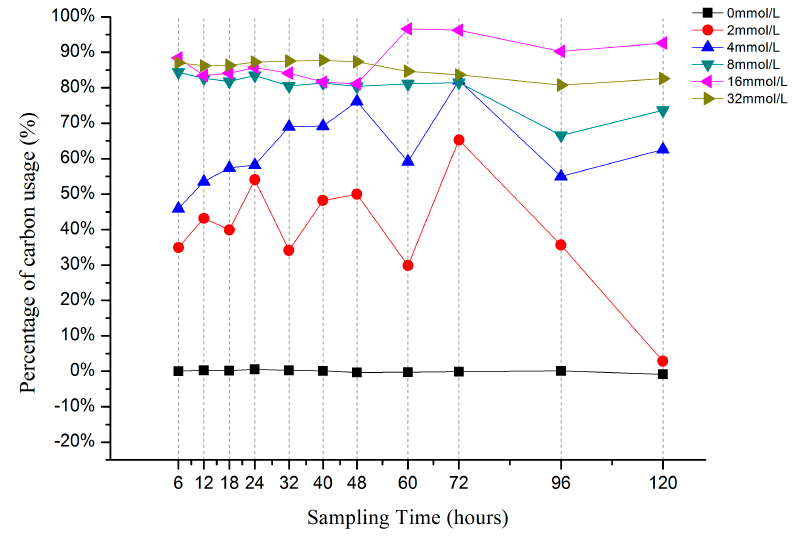
Figure 5. Variation in carbon mass usage percentage.